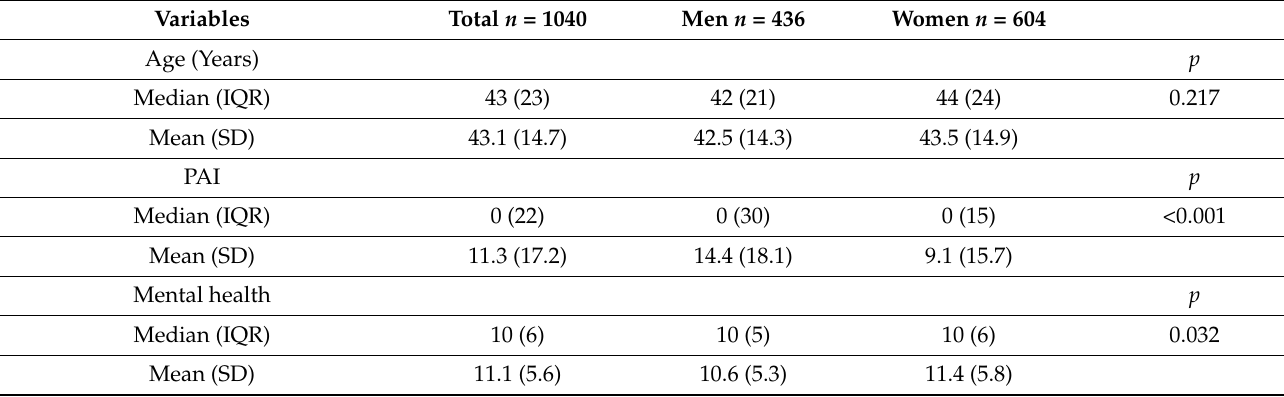
Table 1. Descriptive analysis of the variables studied (PAL, SPH, PSS and mental health dimensions) in Spanish adults with Asthma, according to the ENSE